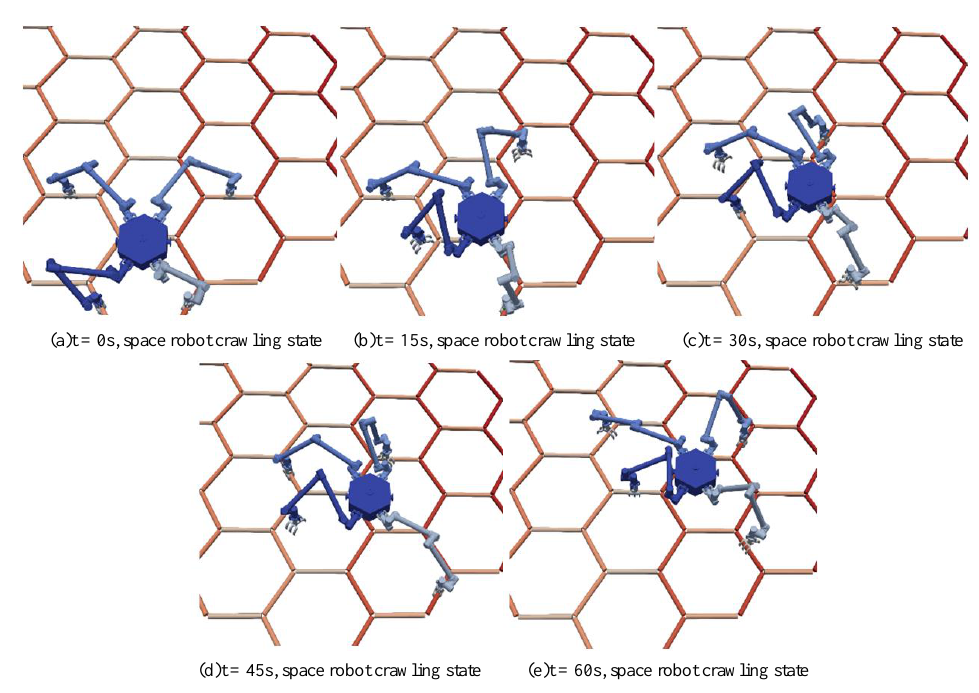
Figure 10. Space robot crawling process.